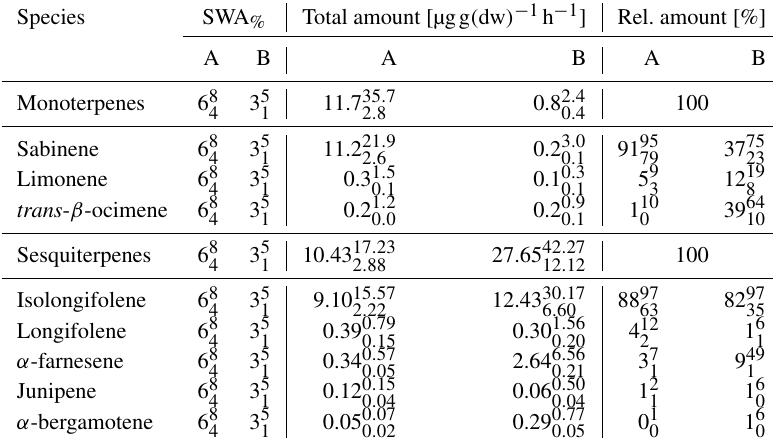
Table 3. Change for individual monoterpene and sesquiterpene species emission fluxes of Fagus sylvatica for two SM conditions (Rombach, 2018). Because of abnormally distributed data, values are stated as the median, 25th percentile (lower) and 75th (upper)